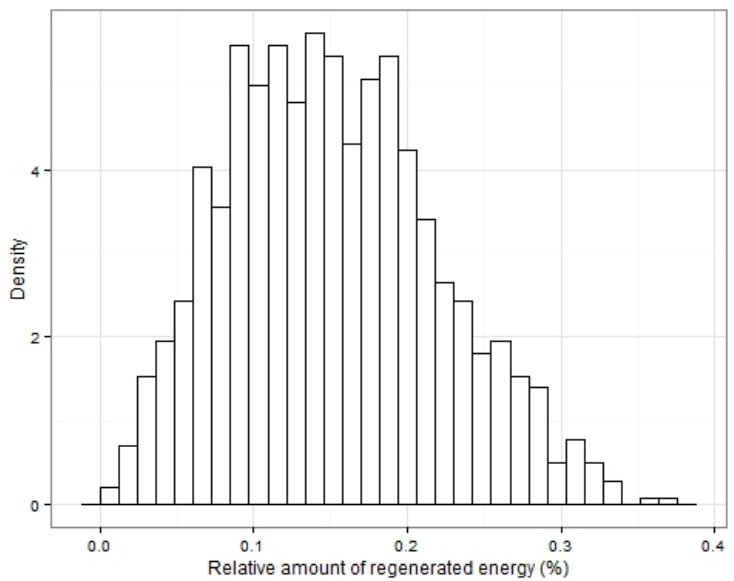
Figure 12. Distribution of regenerated energy percentage for all trips.